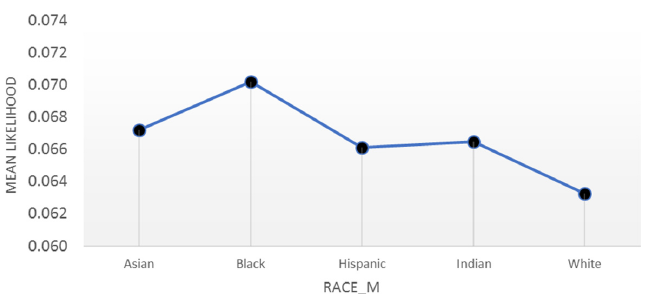
Figure 7. Partial dependence plot for the probability of a preterm based on the mother’s race.